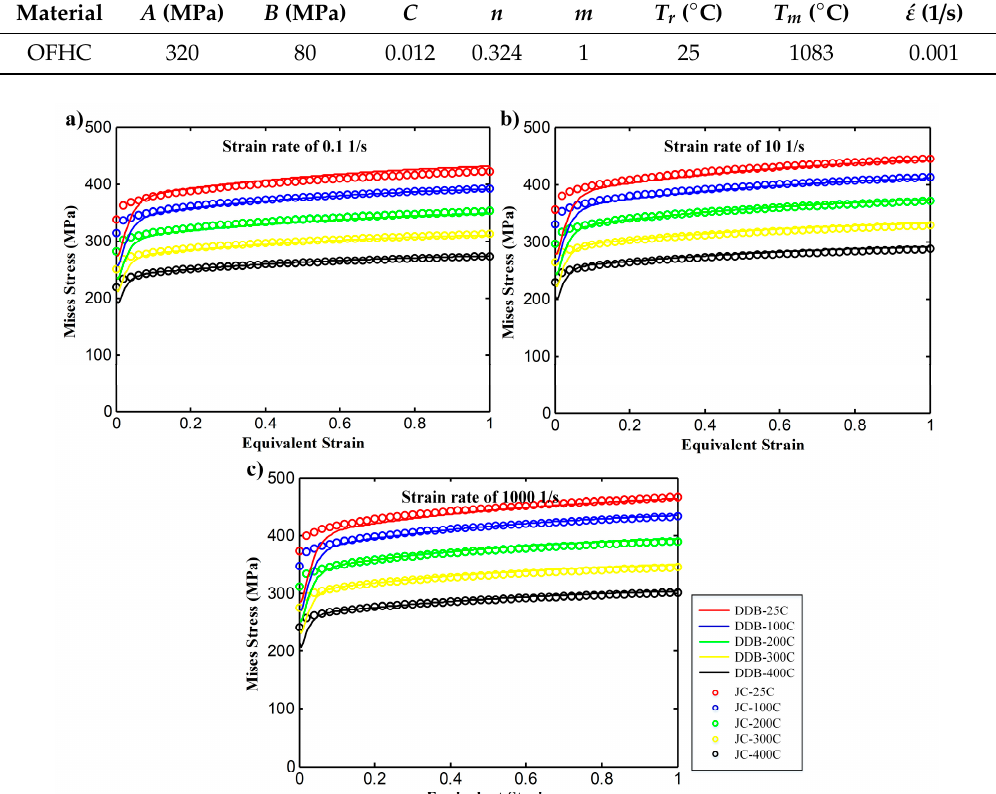
Figure 3. Constitutive behaviors of OFHC copper by DDB model and JC model at different strain rates and temperatures ( a ) strain rate of 0.1s -1 , ( b ) strain rate of 10s -1 and ( c ) strain rate of 1000s -1 .